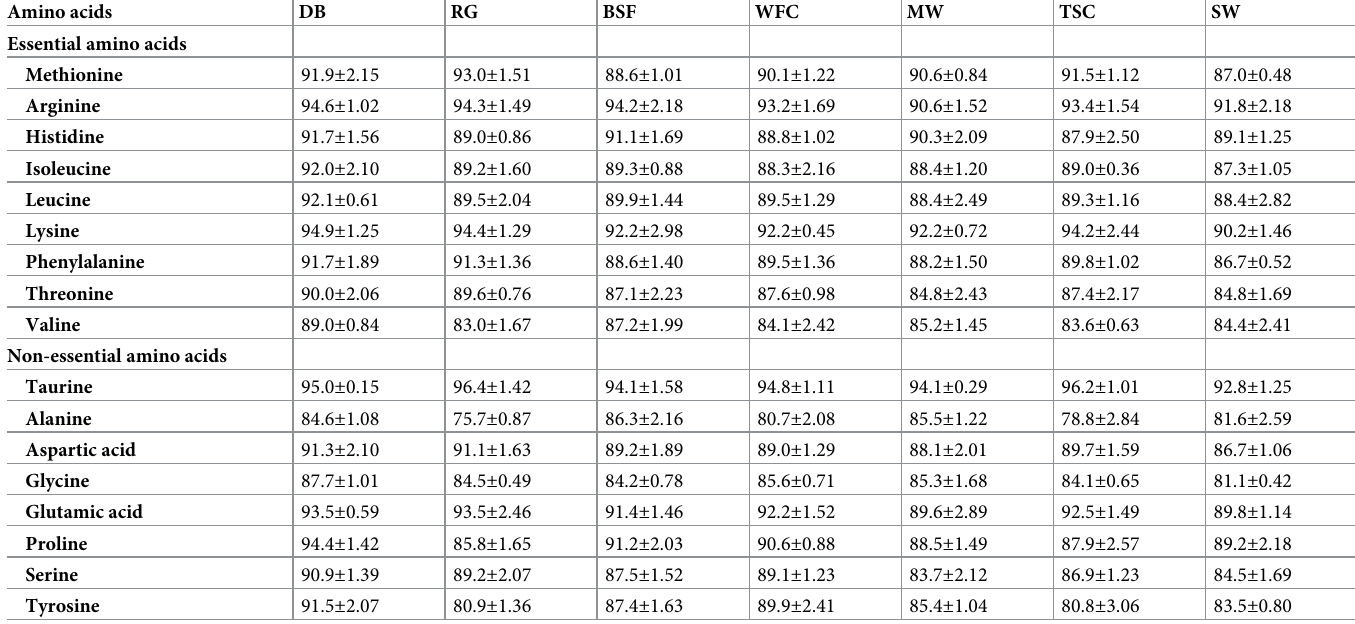
Table 6. Apparent digestibility coefficients (ADCs, %) of essential and non-essential amino acids in the tested insect meals for Pacific white shrimp ( Litopenaeus vannamei